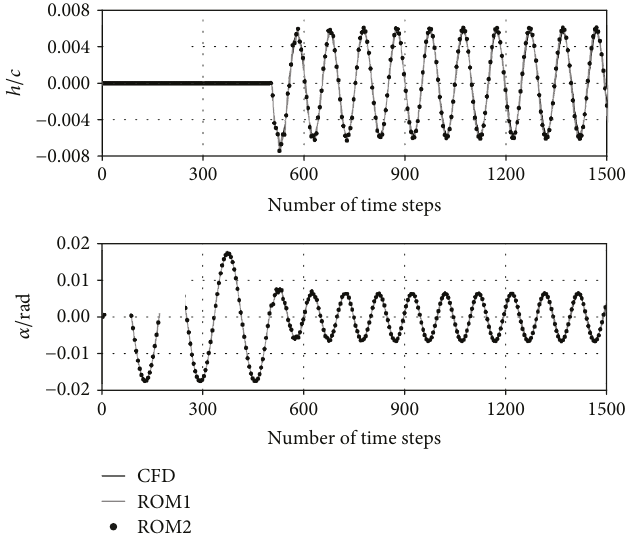
M α = 1 deg (ROM1-training data via CFD; ROM2-training ∞ = 0 85 and ∞ = 0 57 at 0